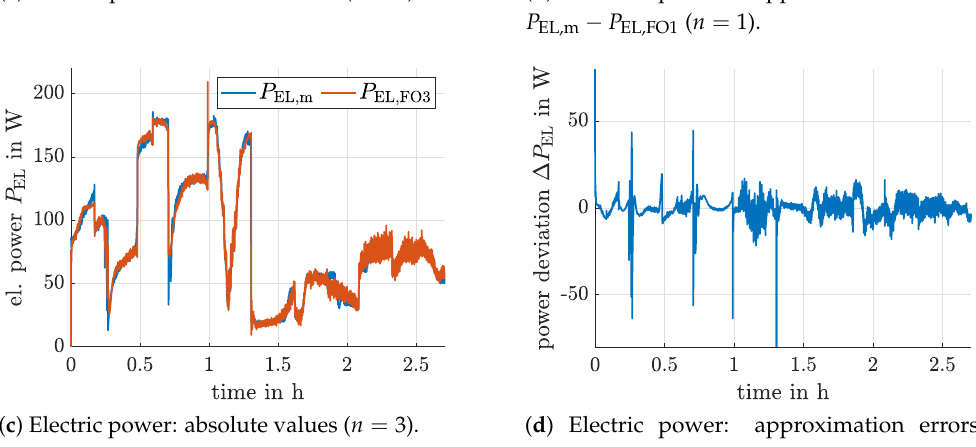
Figure 10. Comparison between measured and estimated stack power, P EL,m and P EL,FO1 (resp., P EL,FO3 ), for the system model in Figure